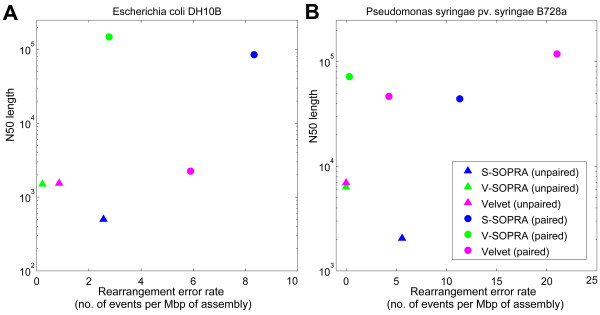
N50 vs. combined rearrangement error rate for de novo assembly of real data. See main text and the caption for Table 1 for explanation of the error rates